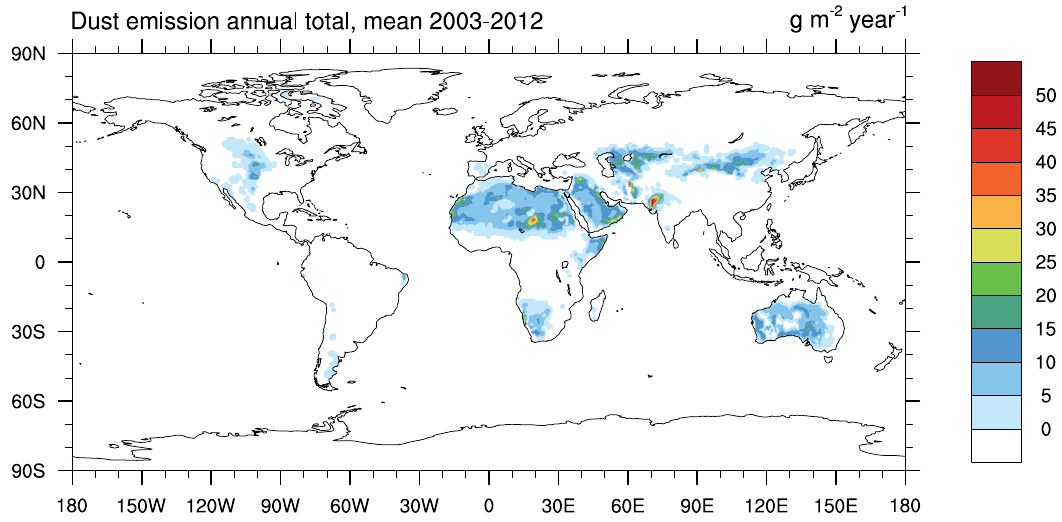
Figure 1. Annual total dust emission fluxes (g m − 2 year − 1 ) averaged over the 10-year period 2003–2012. Data are taken from the ECMWF MACC reanalysis data set at 6-hourly resolution (0UTC, 6UTC,12UTC, and 18UTC) and 0.75 ◦ × 0.75 ◦ grid